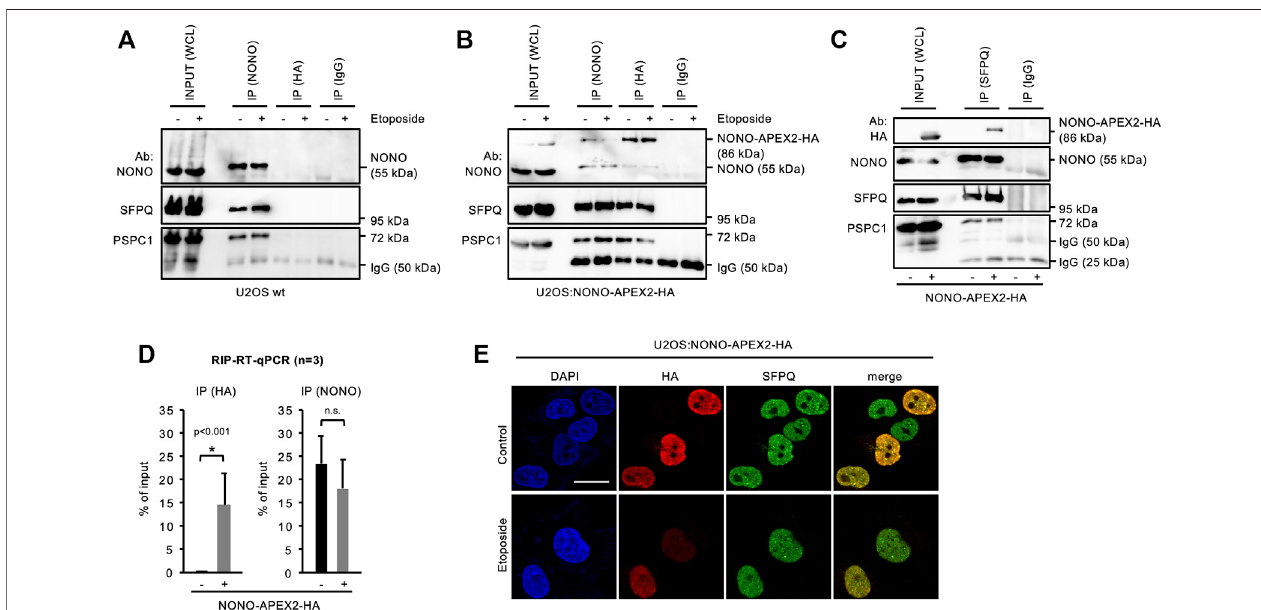
FIGURE3| Interaction ofNONO-APEX2-HA withSFPQand PSPC1. (A – C) Immunoblots detecting NONO, NONO-APEX2-HA, SFPQ and PSPC1 withorwithout (+/-) Etoposide (20 μ M, 2 h) in whole cell lysates (WCL) or upon immunoprecipitation (IP) from wild type (wt) U2OS (A) or U2OS:NONO-APEX2-HA cells (B) or from wt U2OS (-) or U2OS:NONO-APEX2-HA (+) cells (C) . Ab, antibody; IgG, immunoglobulin chain. (D) Reverse-transcriptase quantitative PCR (RT-qPCR) with NEAT1- selective primer upon RNA immunoprecipitation (RIP) from WCL of wt (-) or U2OS:NONO-APEX2-HA (+) cells with the HA antibody (left) or the NONO antibody (right). Asterisk, p < 0.001 (Student ’ s t-test); n.s., not signi fi cant. (E) Confocal imaging of NONO-APEX2-HA and SFPQ ± Etoposide (20 μ M, 2 h). Representative cells are shown. DAPI, 4 ‘ ,6-diamidino-2-phenylindol; scale bar, 10